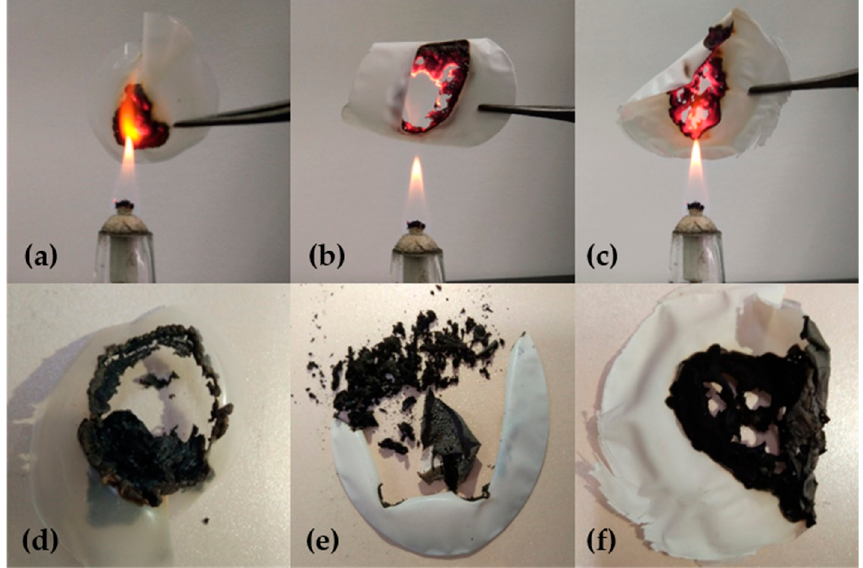
Figure 7. The photographs during and after the burning process of CMC ( a , d ), CMC / MAG–20 ( b , e ), CMC / MAG–40 ( c , f ).